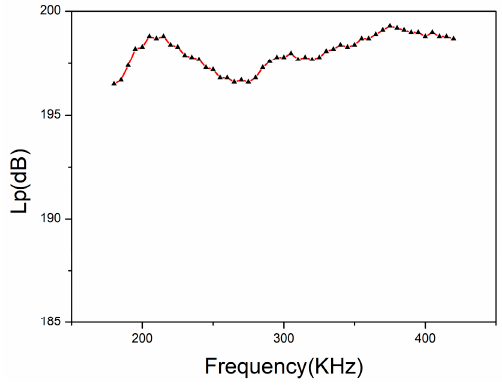
Figure 15. The variation of the emission sound source level with the frequency.